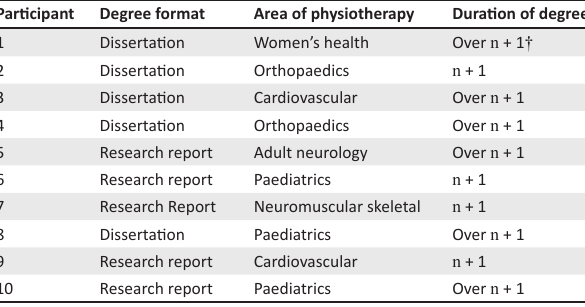
TABLE 1: Description of the